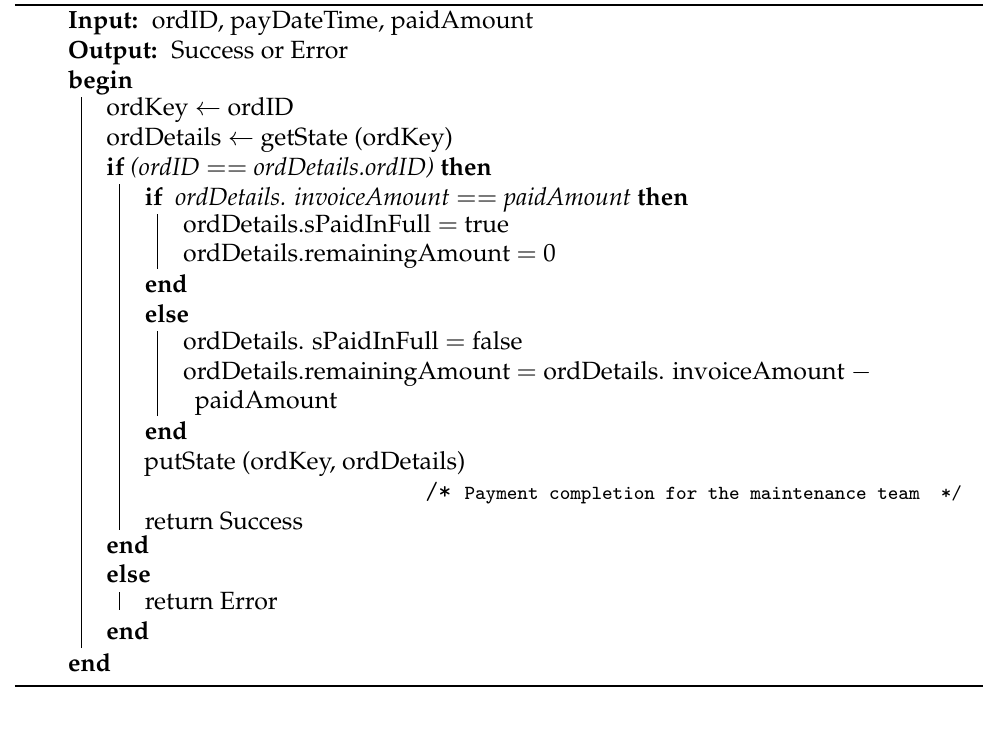
Algorithm 6: Payment to the Maintenance